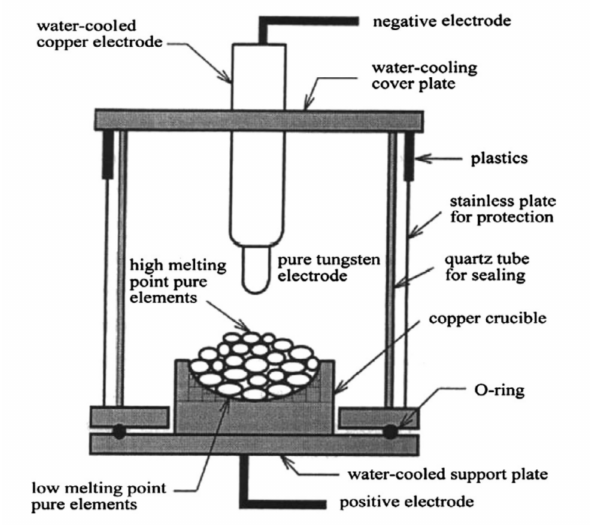
Figure 4. Vacuum arc melting system